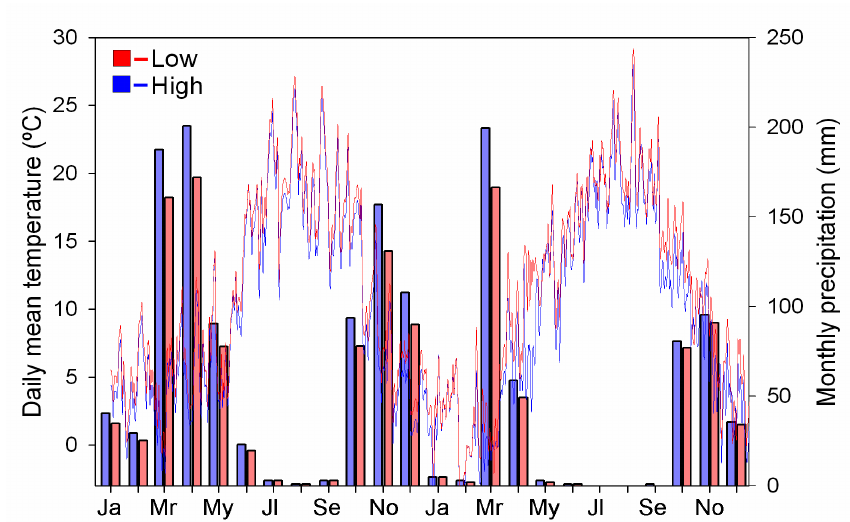
Figure 1. Daily temperature (lines) and monthly precipitation (bars) values for two consecutive growing seasons in two Abies pinsapo populations located along an altitudinal gradient (low elevation, 1200m; high elevation, 1550 m).